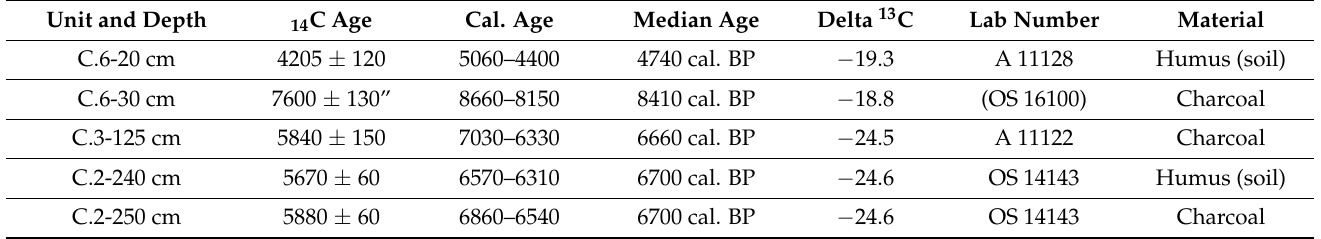
Table 2. Upper Arroyo, Tributary unit, radiocarbon, and AMS dates (rejected dates in parentheses). Reprinted/adapted with permission from Ref. [13], 2008, Karl Butzer. Unit and